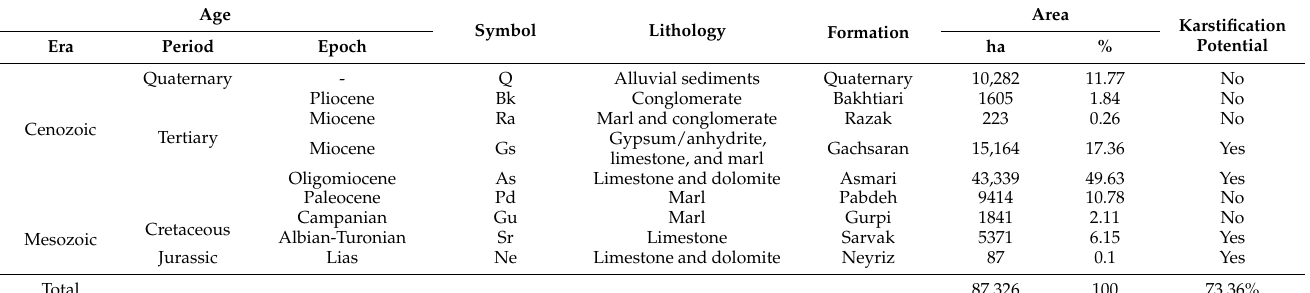
Table 1. Lithological characteristics of the Kabgian